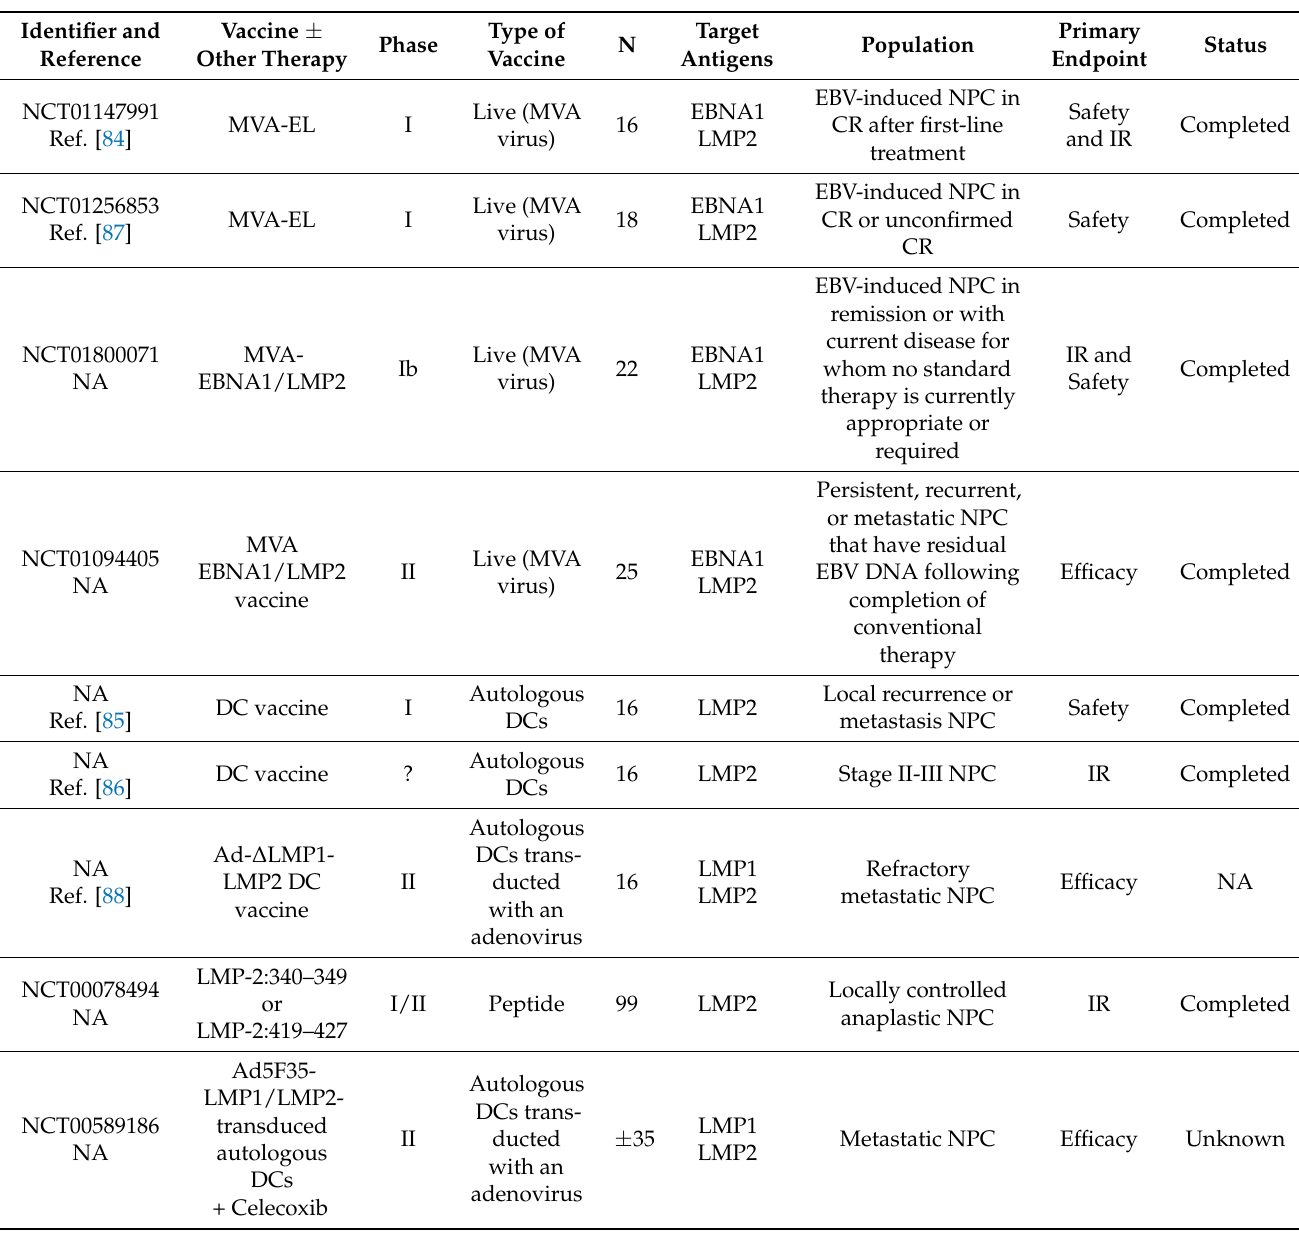
Table 2. Clinical trials in vaccines targeting EBV-associated antigens (non-exhaustive